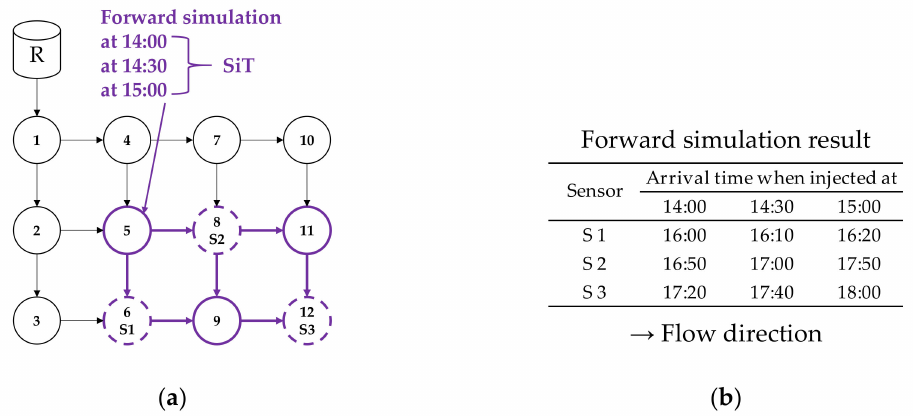
Figure 7. Forward simulation result of the sample network (Node 5 is a SiL): ( a ) Forward tracking paths and ( b ) Arrival times at